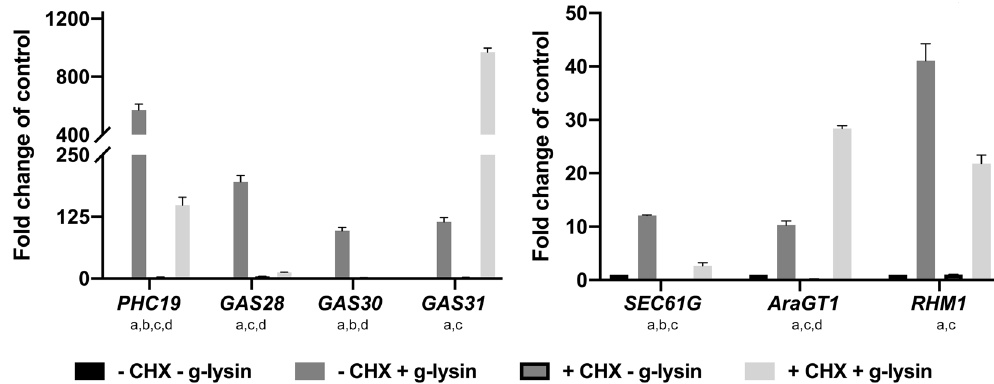
Figure 3. Transcripts are differentially affected by CHX pretreatment prior to gametolysin treatment. ( a , b ) Bar graphs represent the change in gene expression for cell wall protein ( a ) and protein processing type ( b ) CW gene transcripts in wild type (CC-125) cells. Untreated gamete control samples represented by black bars, − CHX − g-lysin; medium grey bars for CHX treated cells, + CHX; dark grey bars for cells treated with g-lysin, + g-lysin; light grey bars for both CHX and g-lysin-treated cells, + CHX + g-lysin. Gene expression is quantified in terms of fold change of the untreated control condition. Error bars represent one standard deviation from the mean of biological triplicate samples. Letters below gene names indicate a significant difference between the specified samples using a two-way ANOVA at p ≤ 0.01; α = 0.05; ‘a’ for − CHX − g-lysin vs . + g-lysin, ‘b’ for − CHX -g-lysin vs . + CHX, ‘c’ for − CHX -g-lysin vs . + CHX + g-lysin, and ‘d’ for + g-lysin vs . + CHX +